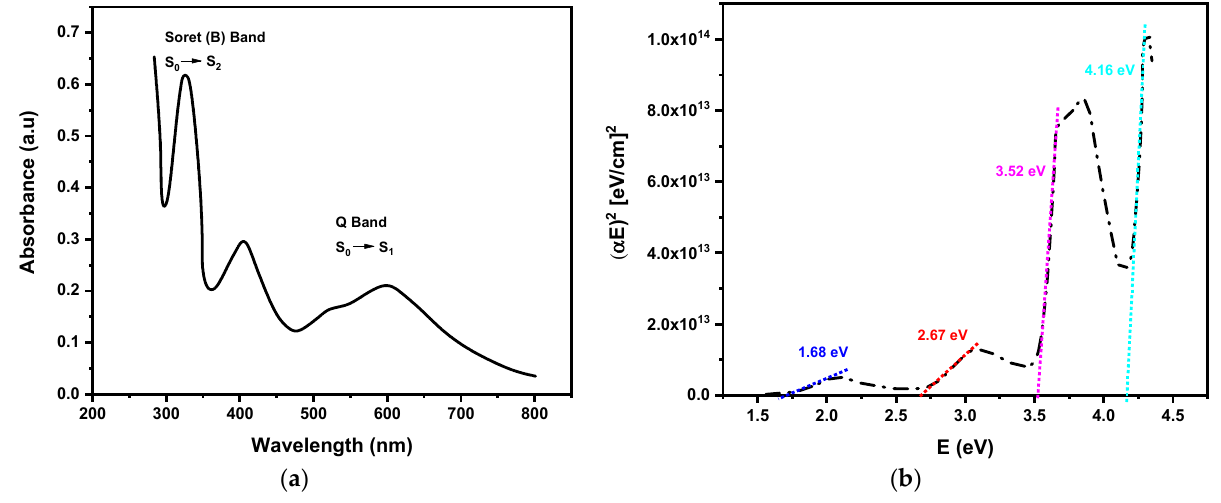
Figure 3. ( a ) UV-Vis absorption spectrum and ( b ) optical energy bandgap of N749-BD.